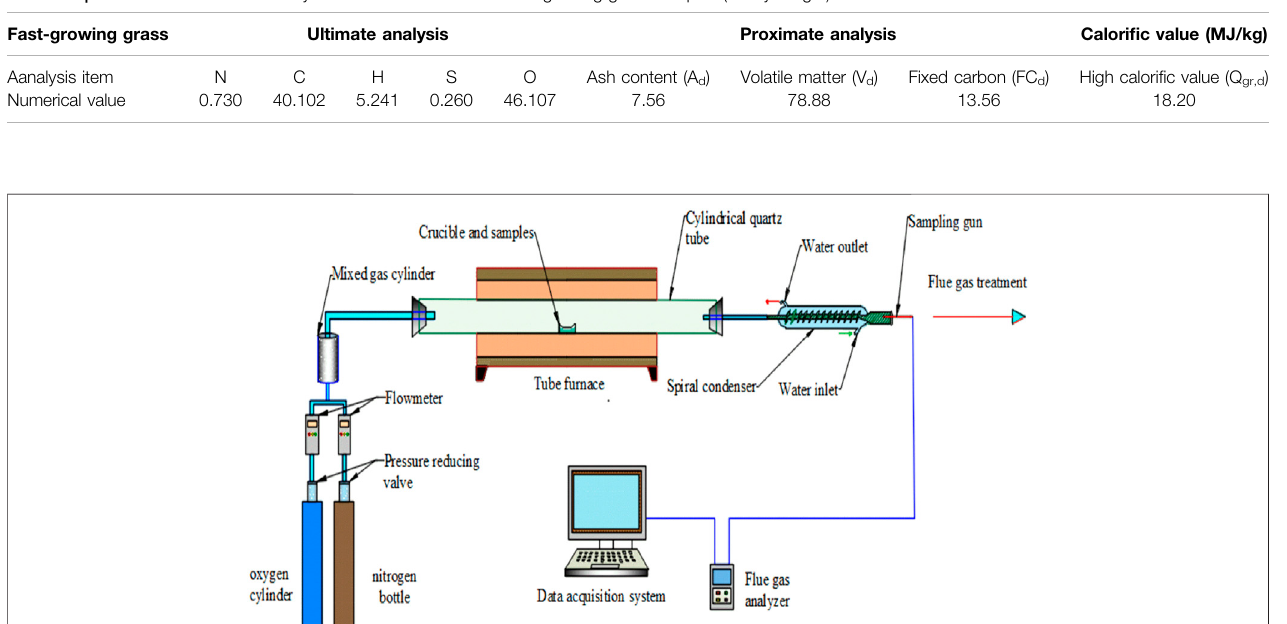
TABLE 1 | Proximate and ultimate analyses and calori fi c values of fast-growing grass samples (% dry weight).